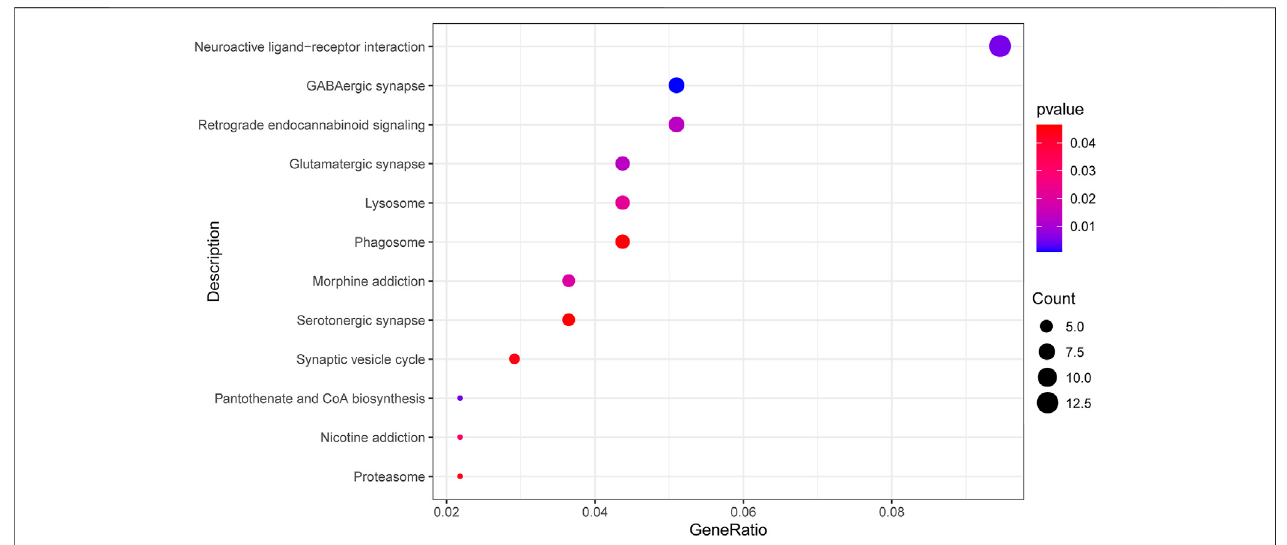
FIGURE3| Top12enrichedKEGGpathwaysofdifferentialmethylationloci-relatedgenes.Thedotsizerepresentsthenumberofgenesinthepathway,andthedot color represents the enrichment p value. KEGG, Kyoto Encyclopedia of Genes and Genomes; GABA, gamma-aminobutyric acid.